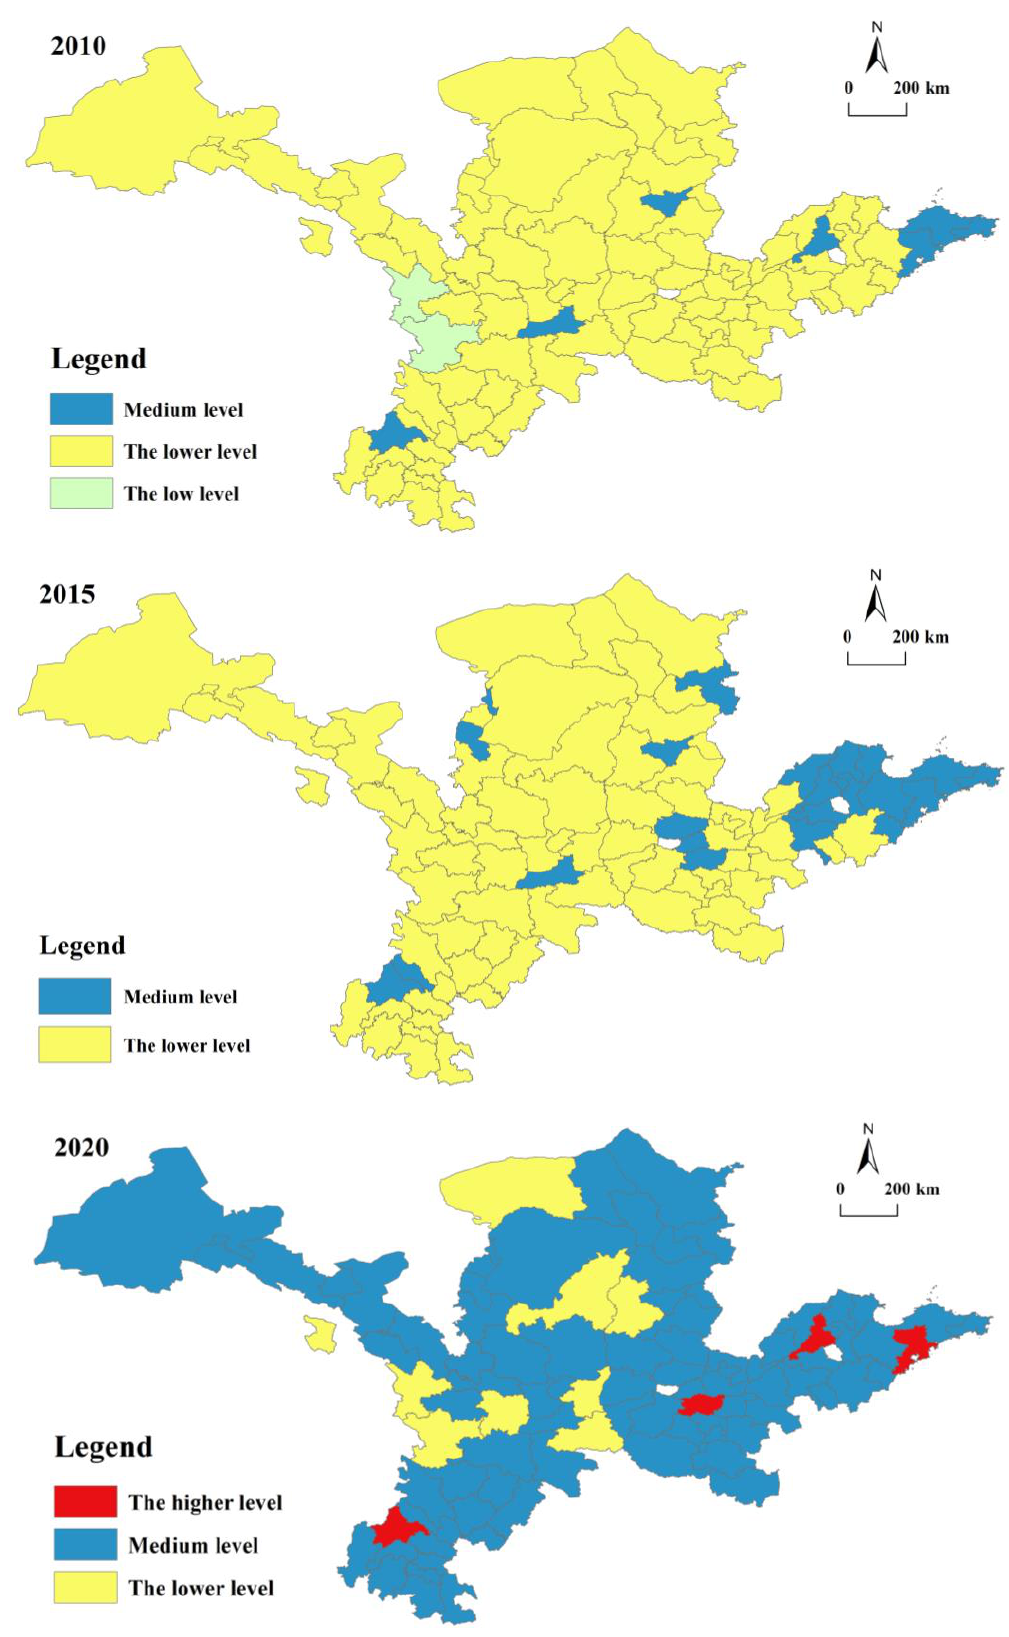
Figure 2. Distribution of urban development levels.